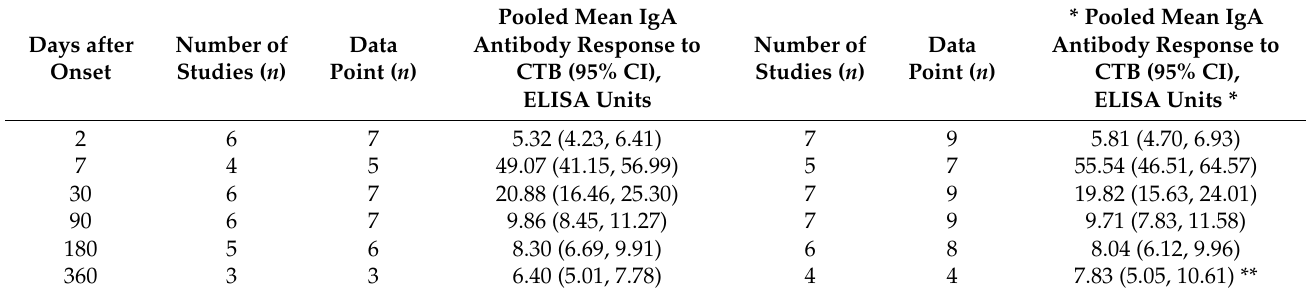
Table 2. Kinetics of anti-cholera toxin B subunit IgA following cholera.